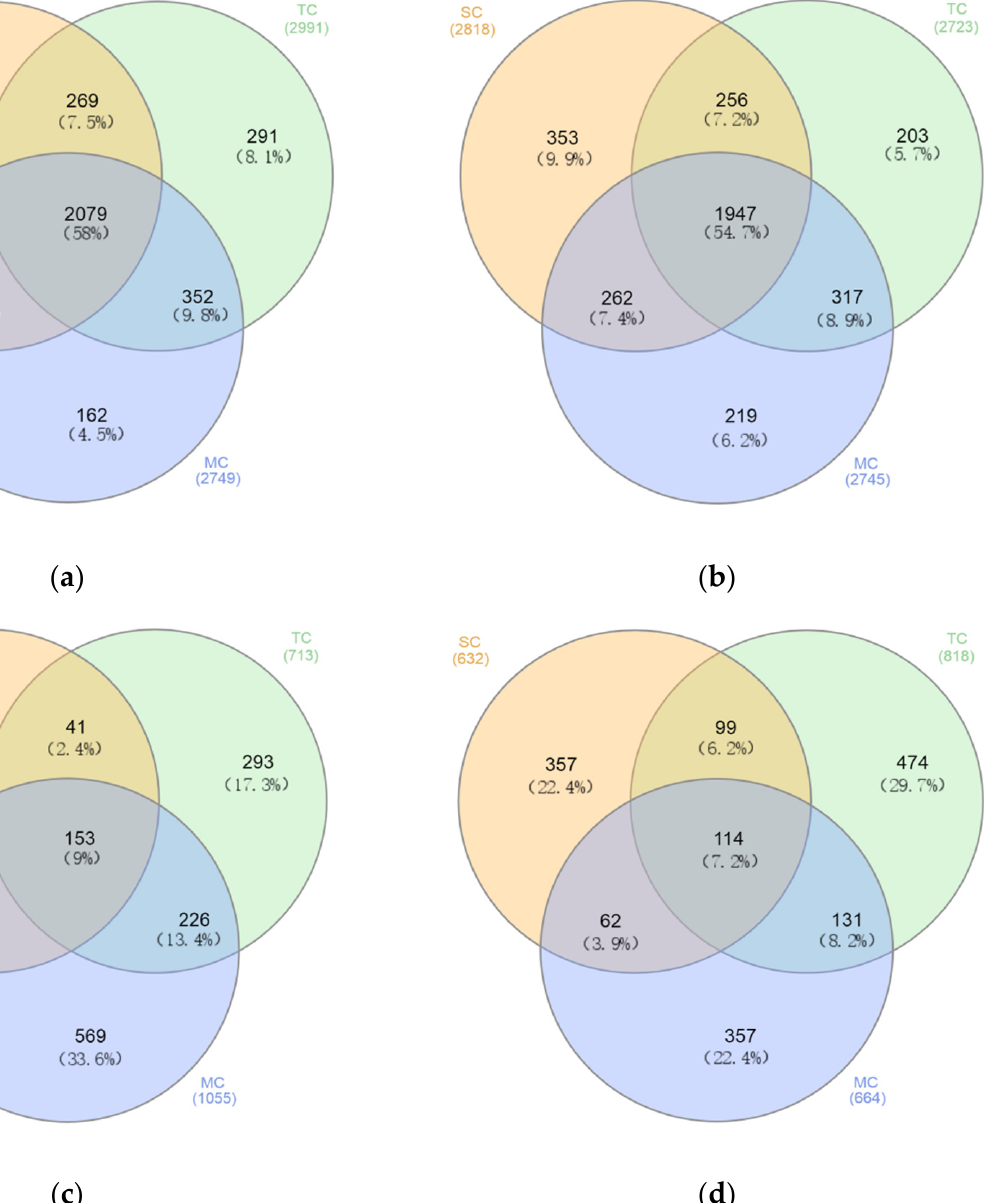
Figure 4. Venn diagram showing the unique and shared OTUs among the SC, TC, and MC samples in soil layer 0–15 cm ( a , c ) and 15–30 cm ( b , d ) in bacterial ( a , b ) and fungal ( c , d ) communities. The first and second axes of PCoA analysis based on the OTUs data of bacterial community explained 27.44% and 18.82% of the variance, respectively (Figure 5a). However, using the OTUs data of fungal communities, the first and second axes of PCoA analysis explained 23.10% and 12.38% of the variance, respectively (Figure